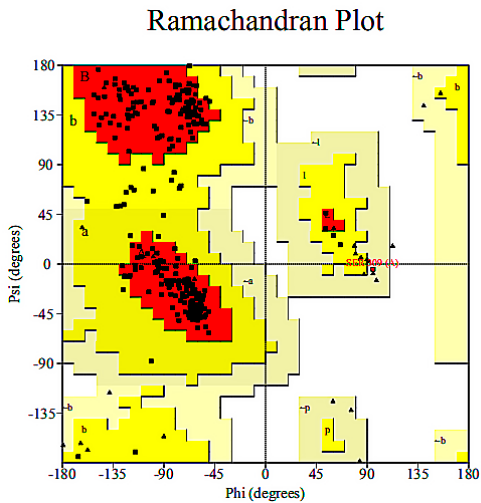
Figure 3. Ramachandran conformational map of a novel degrading enzyme (1-1).